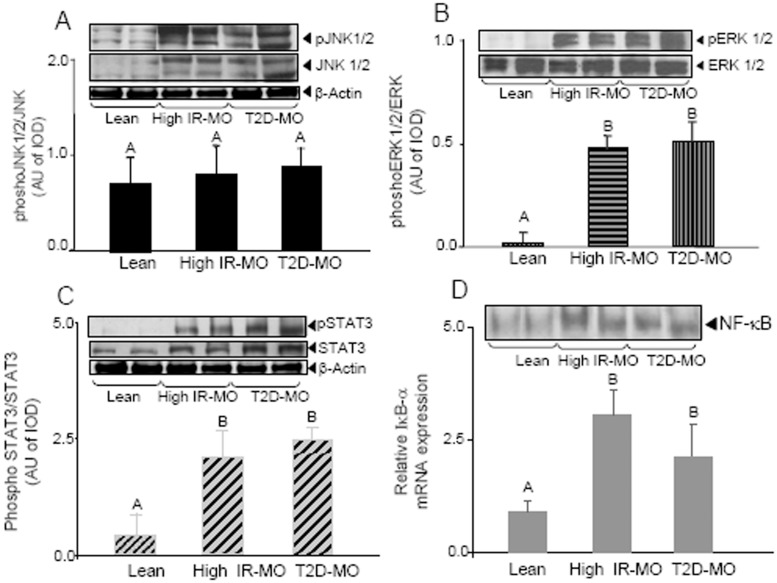
Intracellular inflammatory pathways in visceral adipose tissue from non obese, high IR-MO and T2D-MO individuals.(A) Expression and phosphorylation of JNK 1/2 isoforms: All obese patients, independently of high degree of insulin resistance and diabetes state, had significantly elevated levels of JNK 1 and 2 expression and phosphorylation versus lean group. (B) Expression and activation of ERK1/2 isoforms: All samples had similar levels of constitutive ERK 1/2 expression. VAT of lean subjects showed an undetectable ERK1/2 activation, in contrast to the high levels of ERK 1/2 activation seen in morbid obese patients (high IR-MO and T2D-MO). No significant differences were observed between both obese groups. (C) Expression and phosphorylation of STAT3: Both, phosphorylation and expression of STAT3 were significantly increased in VAT from MO individuals versus lean controls. Although there were not differences in the observed phosphorylation of STAT3 between high IR-MO and diabetic groups, elevated levels of expression were seen in diabetic individuals comparing with high IR-MO. (D) NF-κB pathway: There was a significant increase of IκB-α mRNA expression in VAT of MO compared to non obese subjects. Moreover, there were no significant differences in the high levels observed in both morbidly obese groups. EMSA technique revealed that NF-κB activation was significantly elevated in VAT of MO patients compared to the low levels seen in lean individuals. NF-κB activity levels were similar when the MO group was divided in high IR and T2D subgroup. Significant differences (Duncan; p<0.05) are indicated with different words.